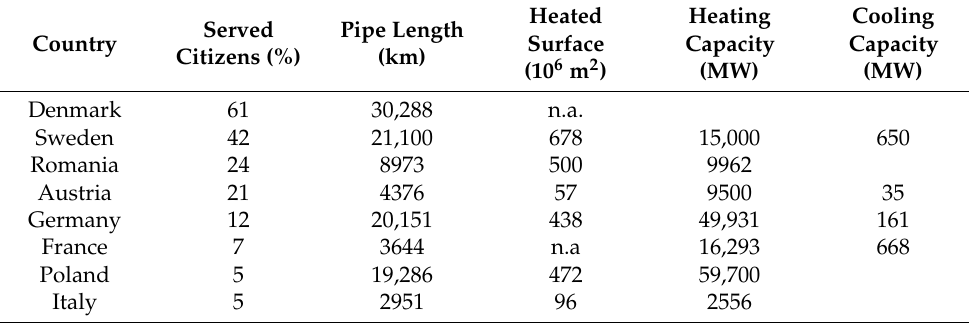
Table 1. Extension of district heating systems in several EU nations [5].